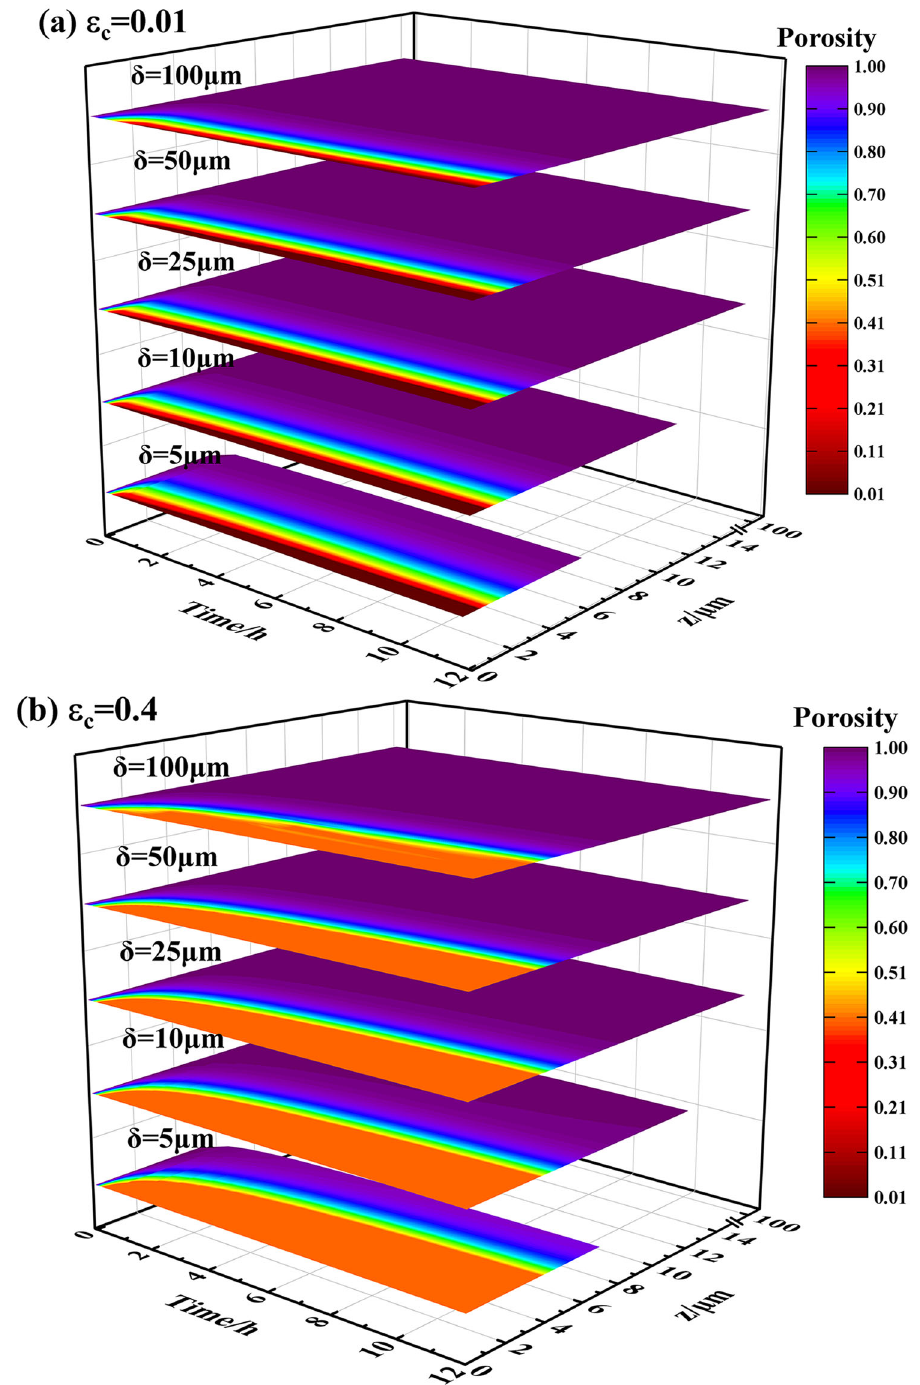
Fig. 2 Time evolution of corrosion products porosities along the longitudinal distribution under electrolyte fi lm with different thicknesses. a the ε c of corrosion products is 0.01. b the ε c of corrosion products is